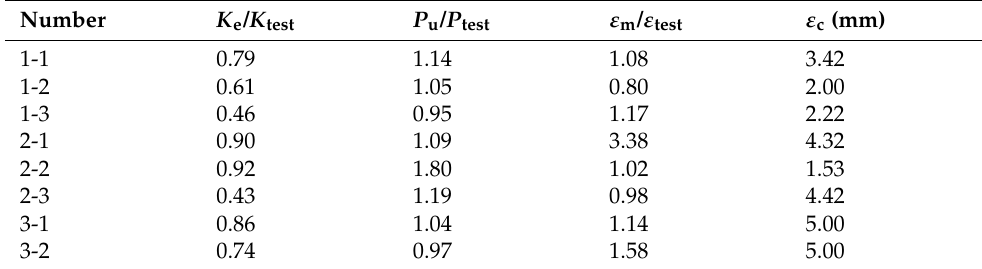
Table 9. Comparison between FEA results and test